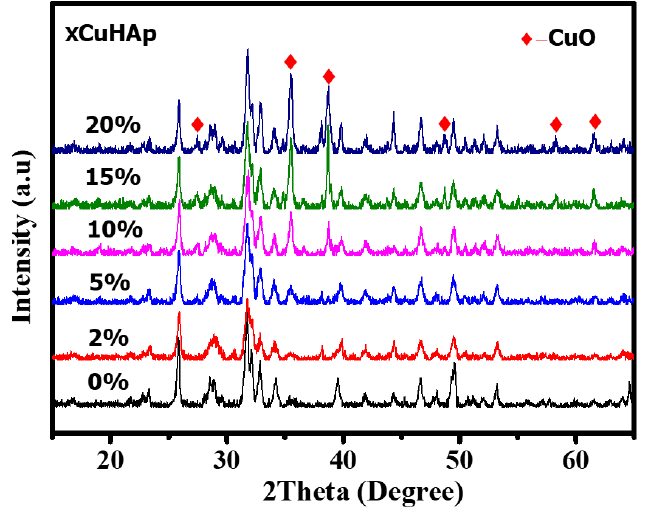
ff ractograms of CuHAp catalysts with di ff erent Cu Figure 1. X-ray diffractograms of CuHAp catalysts with different Cu loadings. Figure 1. X-ray di